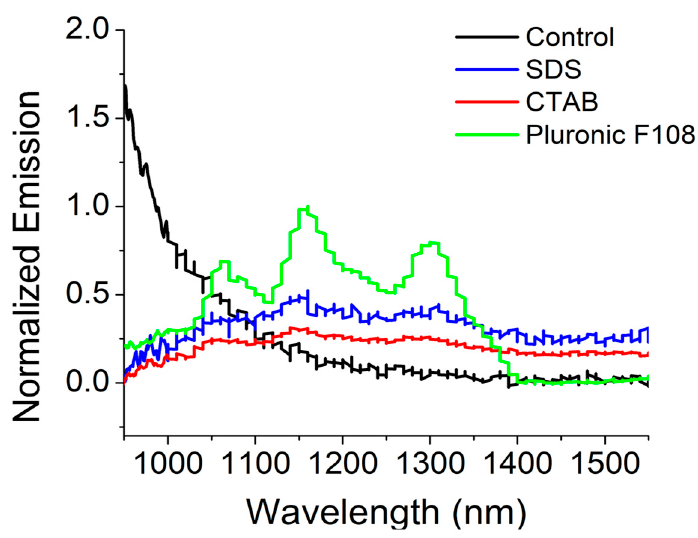
Figure 2. Near-infrared (NIR) photoluminescence spectra of different surfactant/SWCNT-based hydrogels.